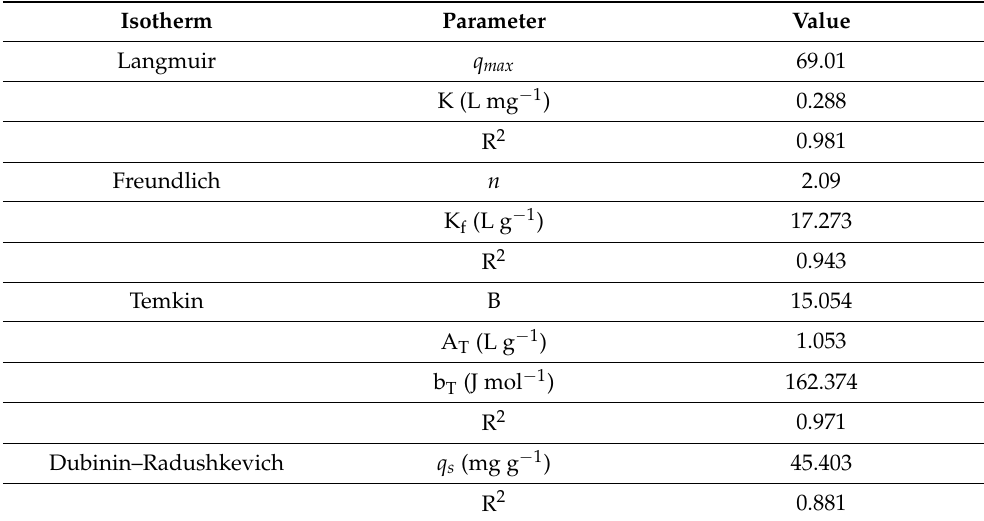
Figure 8. Fitting of equilibrium data to the different adsorption isotherms; ( a ) Langmuir, ( b ) Fre- undlich, ( c ) Temkin, and ( d ) Dubinin–Radushkevich. Table 3. Summary of isotherms